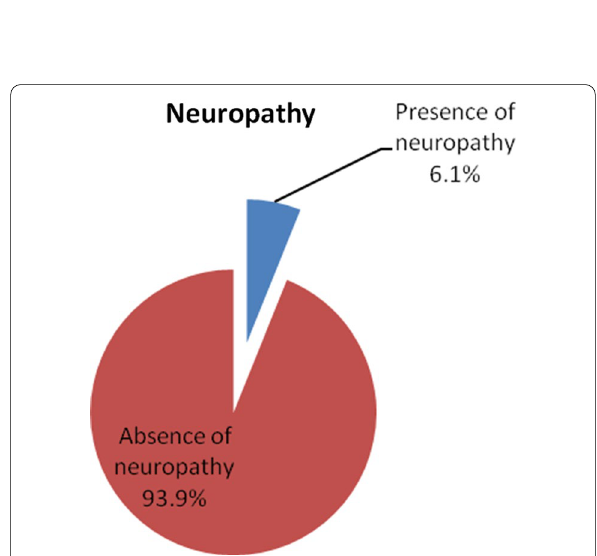
Fig. 2 The frequency of diabetic neuropathy among Sudanese patients with type 2 diabetes mellitus (expressed in percentages, n =